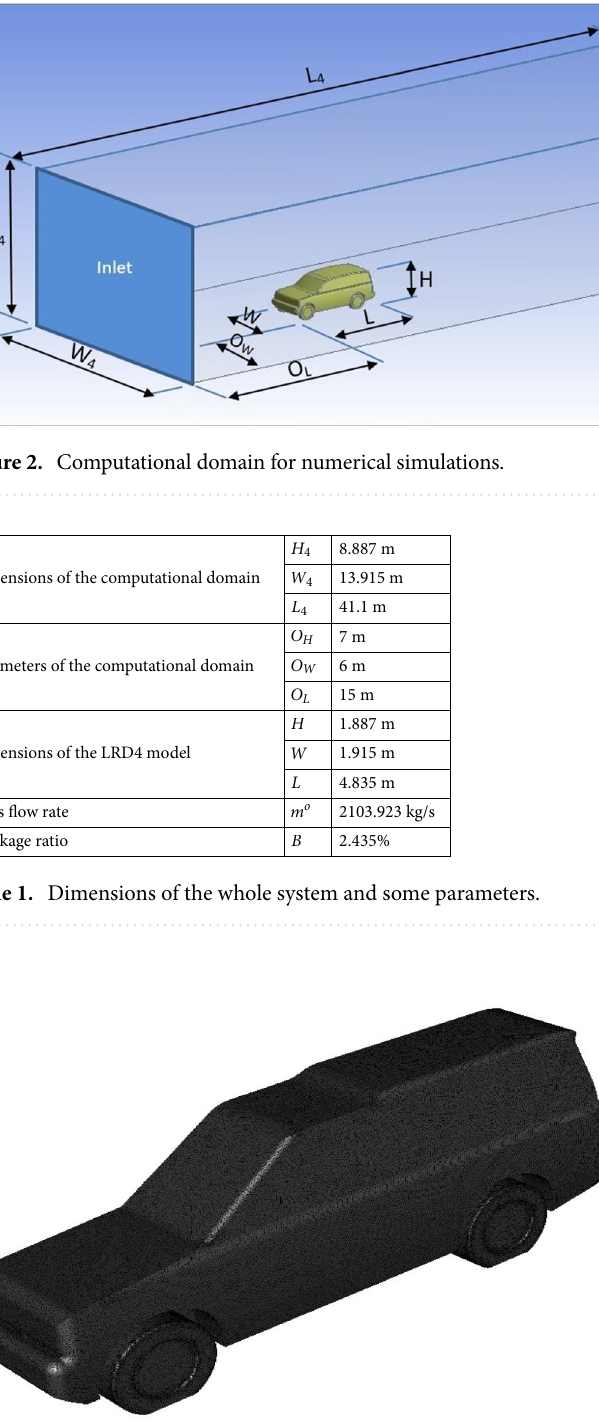
Figure 3. Surface mesh of the